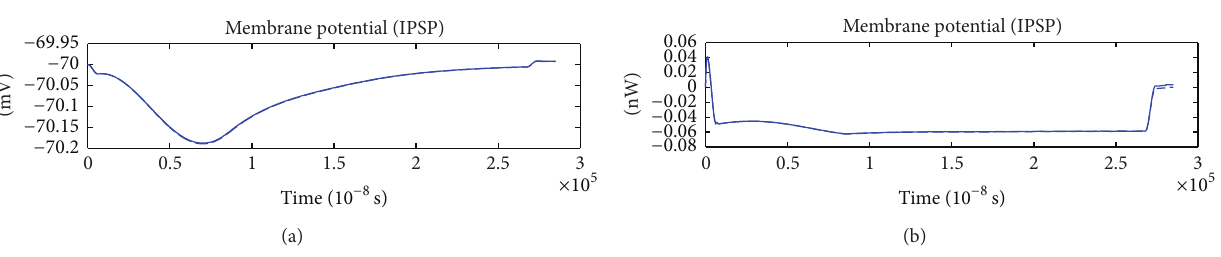
Figure 22: The IPSP and the corresponding energy function. 𝑟 0𝑚 = 0.0001 Ω , 𝑟 1𝑚 = 0.1 Ω , 𝑟 2𝑚 = 1000 Ω , 𝑟 3𝑚 = 0.1 Ω , 𝑟 𝑚 = 1000 Ω , = 1 𝜇 F, 𝐿 = 50 𝜇 H, 𝑖 = −0.7 𝜇 A, and 𝑄 = 1 × 10 −7 𝜇 𝐶 𝑚 𝑚 0𝑚